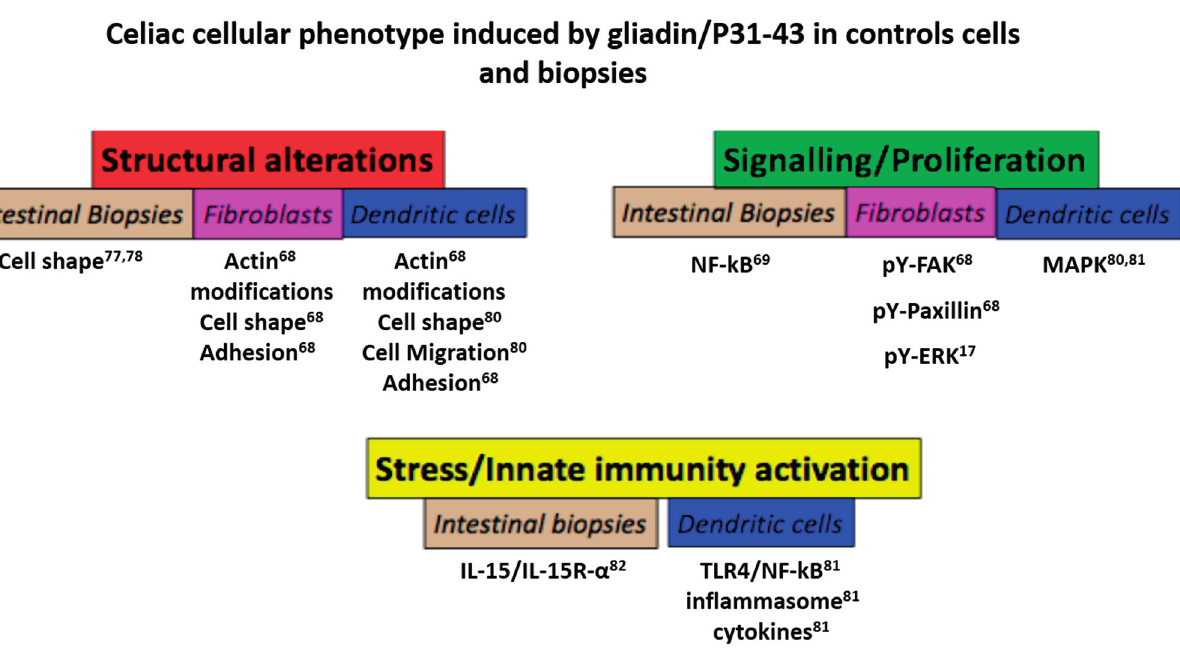
Figure 5. Celiac cellular phenotype induced by gliadin/P31–43 in control cells and biopsies. Schematic representation of the effects of gliadin peptide P31–43 on cells and biopsies from normal subjects. The main effects were grouped in three sets: structural alterations (actin modifications, cell shape, adhesion and cell migration), signaling/proliferation (NF- κ B, pY-Fak, pY-paxillin, pY-ERK) and stress/innate immunity activation. In all cases, there